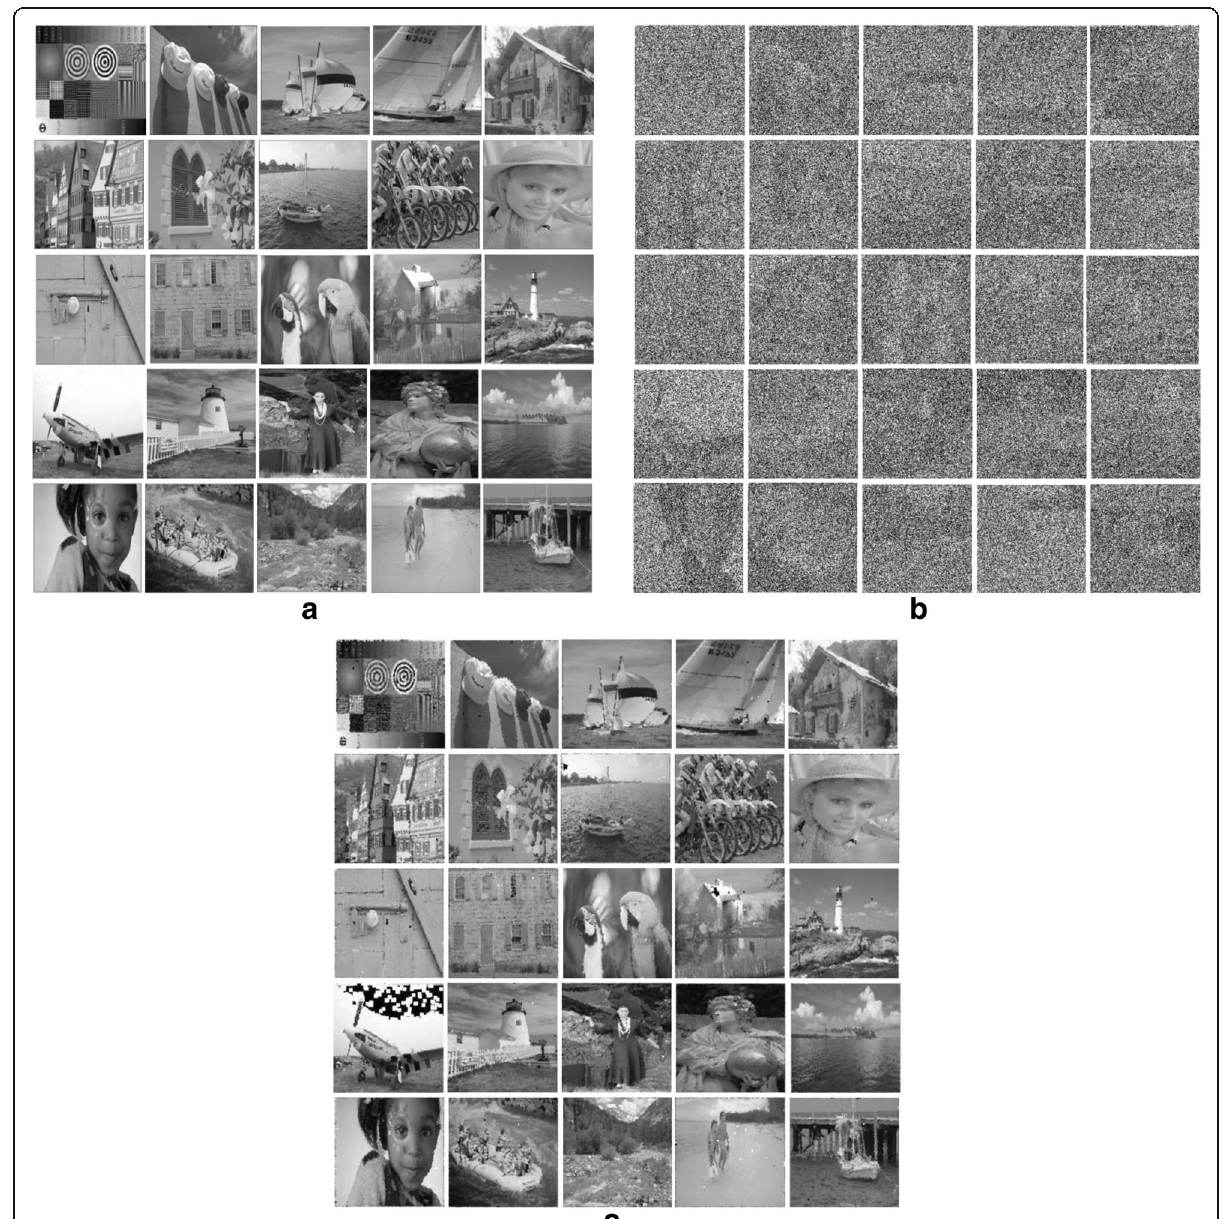
Fig. 11 Restoration results of TTSD algorithm for TID2008 database corrupted with 80% noise density. Legends: a TID2008 database (25 original images); b TID2008 noisy images (80%); c TID2008 database images restored by TTSD